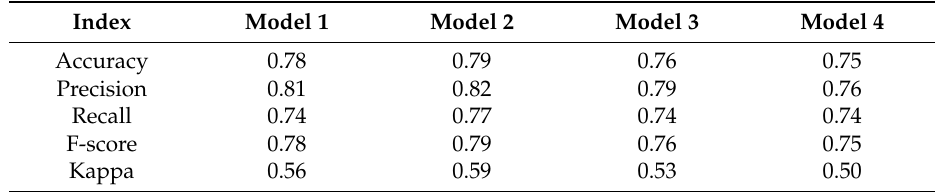
Table 2. Result of models in testing